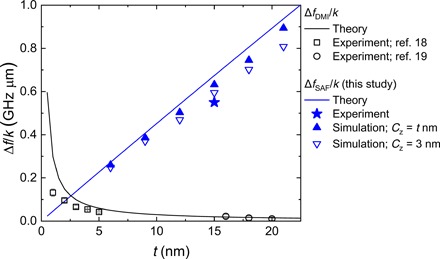
Comparison of the nonreciprocal frequency shift.The nonreciprocal frequency shift divided by the wave number Δf/k as a function of the ferromagnetic layer thickness. The i-DMI contribution in the artificial structure (ΔfDMI/k, black line) and dipolar contribution in SAFs (ΔfSAF/k, blue line) are calculated from 2γDs/(πMst) and Eq. 2, respectively, with γ = 1.89 × 1011 rad/Ts, Ds = 3 pJ/m, Ms = 1.21 × 106 A/m, and sin ϕ0 = 1. Previously reported results in Pt/Co/AlOx measured by Brillouin light scattering (squares) and Pt/Co/MgO measured by propagating spin wave spectroscopy (circles) are shown. A star symbol represents the experimentally obtained value in this study for μ0Hext,L = 10 mT. The filled and open triangle correspond to ΔfSAF/k calculated by micromagnetic simulation with Cz = t nm and Cz = 3 nm, respectively, where Cz is the cell size of z direction.